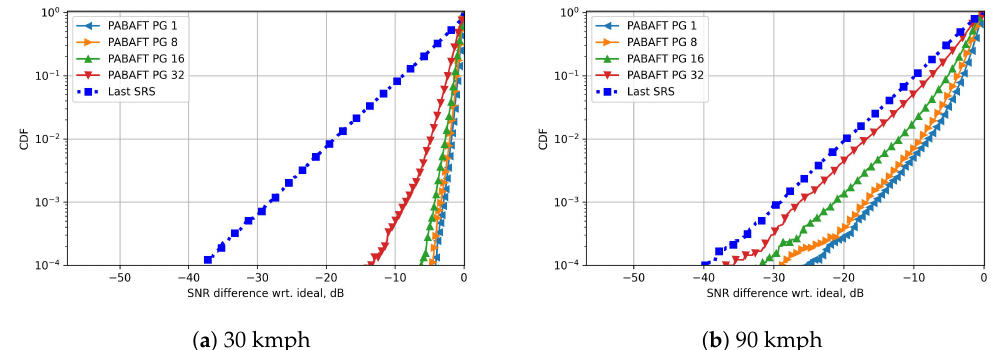
Figure 5. The influence of the number of aggregated PGs on the accuracy of channel